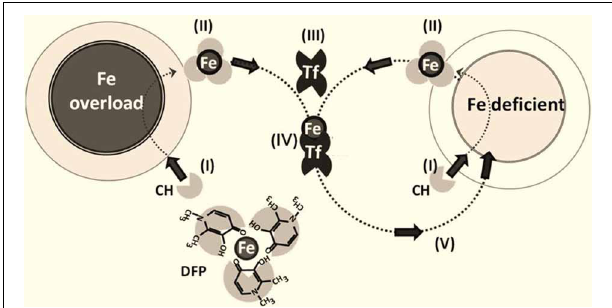
FIGURE 2 | Iron chelation and redeployment. The redeployment strategy leans on permeant chelators (CH) (I) that gain access to cells (normal or Fe-overloaded), (II) chelate labile cell iron and, following egress from cells into plasma, transfer (III) the chelated Fe to circulating apotransferrin Tf to form TfFe (IV) , which in turn re-deploys the metal to Fe-deficient cells (V) in a conservative cycle. The various steps in the chelation-redeployment cycle have been demonstrated preclinically with the bidentate Fe (III) chelator deferiprone (DFP) (Sohn et al., 2011; Kakhlon et al., 2010; Fleming and Ponka, 2012). Given that DFP-Fe chelates donate metal to cell or plasma iron-acceptors (e.g., apo-Tf), the modus operandii of the chelators resembles siderophores or chaperons that redistribute iron across cells and their